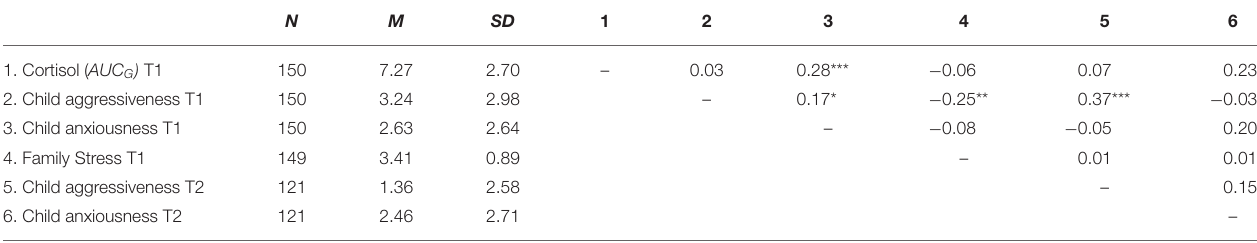
TABLE 1 | Descriptive statistics and correlations for study